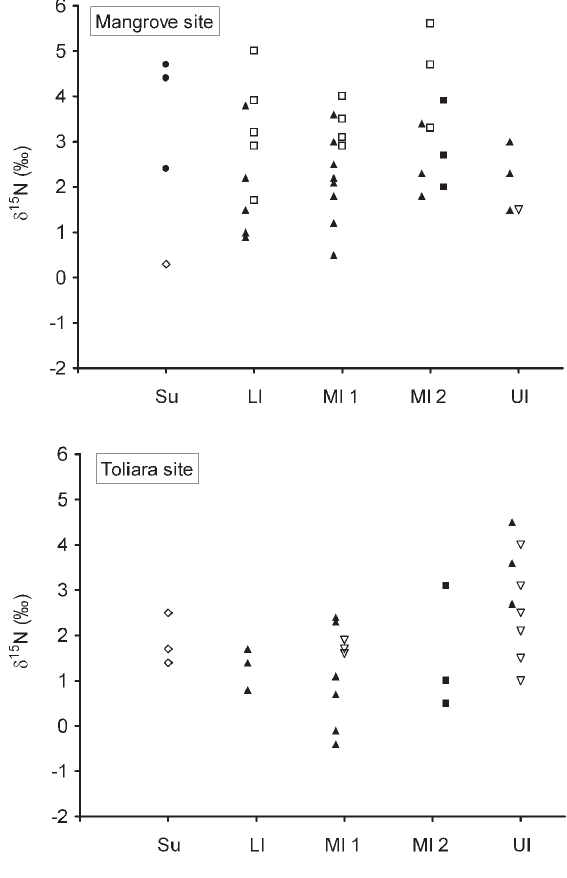
Fig . 3. – nitrogen isotope ratios measured in seagrass species col- lected on toliara Beach and Beloza mangrove (madagascar). (sub: subtidal; li: low intertidal; mi1: mid-intertidal community 1, mi2: mid-intertidal community 2; ui: upper intertidal). ¢ : Cymodocea rotundata , £ : Thalassia hemprichii , ò : Thalassodendron ciliatum , p : Halodule sp., s : Halophila ovalis, ◊ : Syringodium isoetifolium .